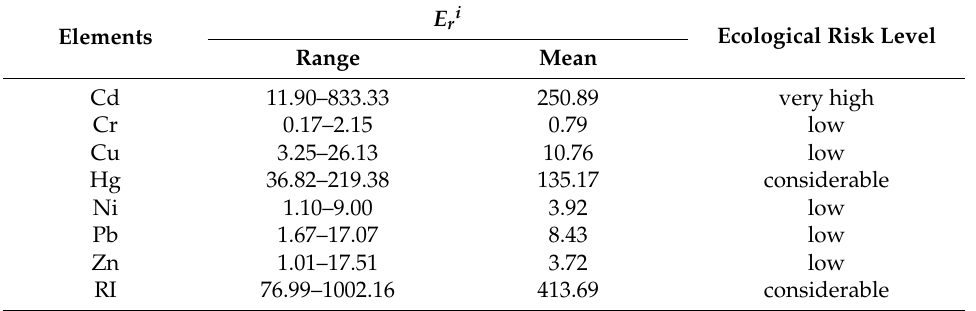
Table 7. Potential ecological risk assessment of heavy metals in Taizhou following atmospheric deposition.